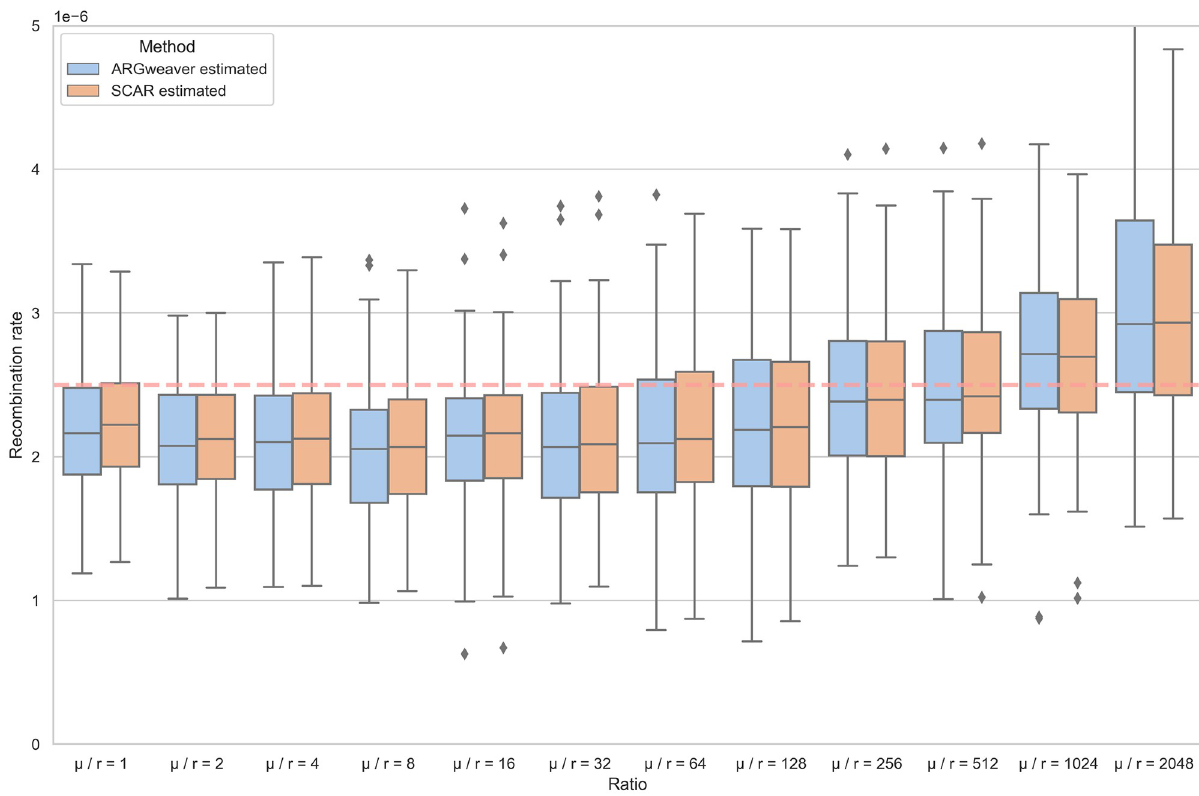
Fig 6. Recombination rates estimated using ARGweaver and SCAR from ARGs inferred by ARGweaver under different μ / r ratios. The dashed red line is the simulated recombination rate in all simulations. Under each μ / r ratio, 100 simulations were run.